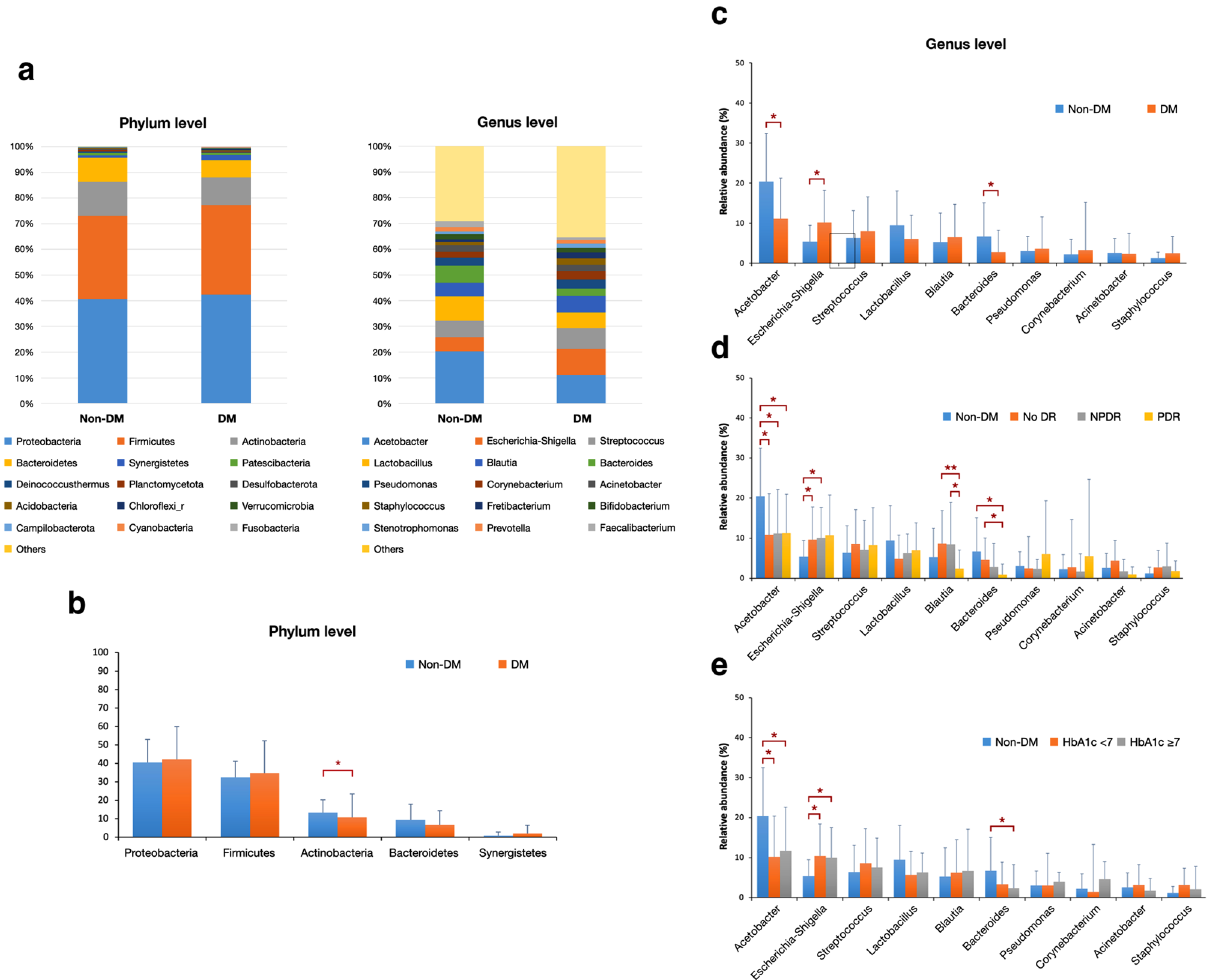
Figure 1. Taxonomic composition ( a ) Top 15 bacteria in phylum and genus levels of the ocular surface microbiome in the non-DM and DM groups. ( b ) Comparison of top 5 phyla between the non-DM and DM groups. ( c ) Comparison of top 10 genera between the non-DM and DM groups, ( d ) between the non-DM and DM subgroups classified by DR staging, and ( e ) between the non-DM and DM subgroups classified by glycemic control. * p value < 0.05; ** p value < 0.001. (Abbreviations: DM diabetes mellitus, Non-DM non-diabetes mellitus, No DR no diabetic retinopathy, NPDR non-proliferative diabetic retinopathy, PDR proliferative diabetic retinopathy, HbA1c hemoglobin